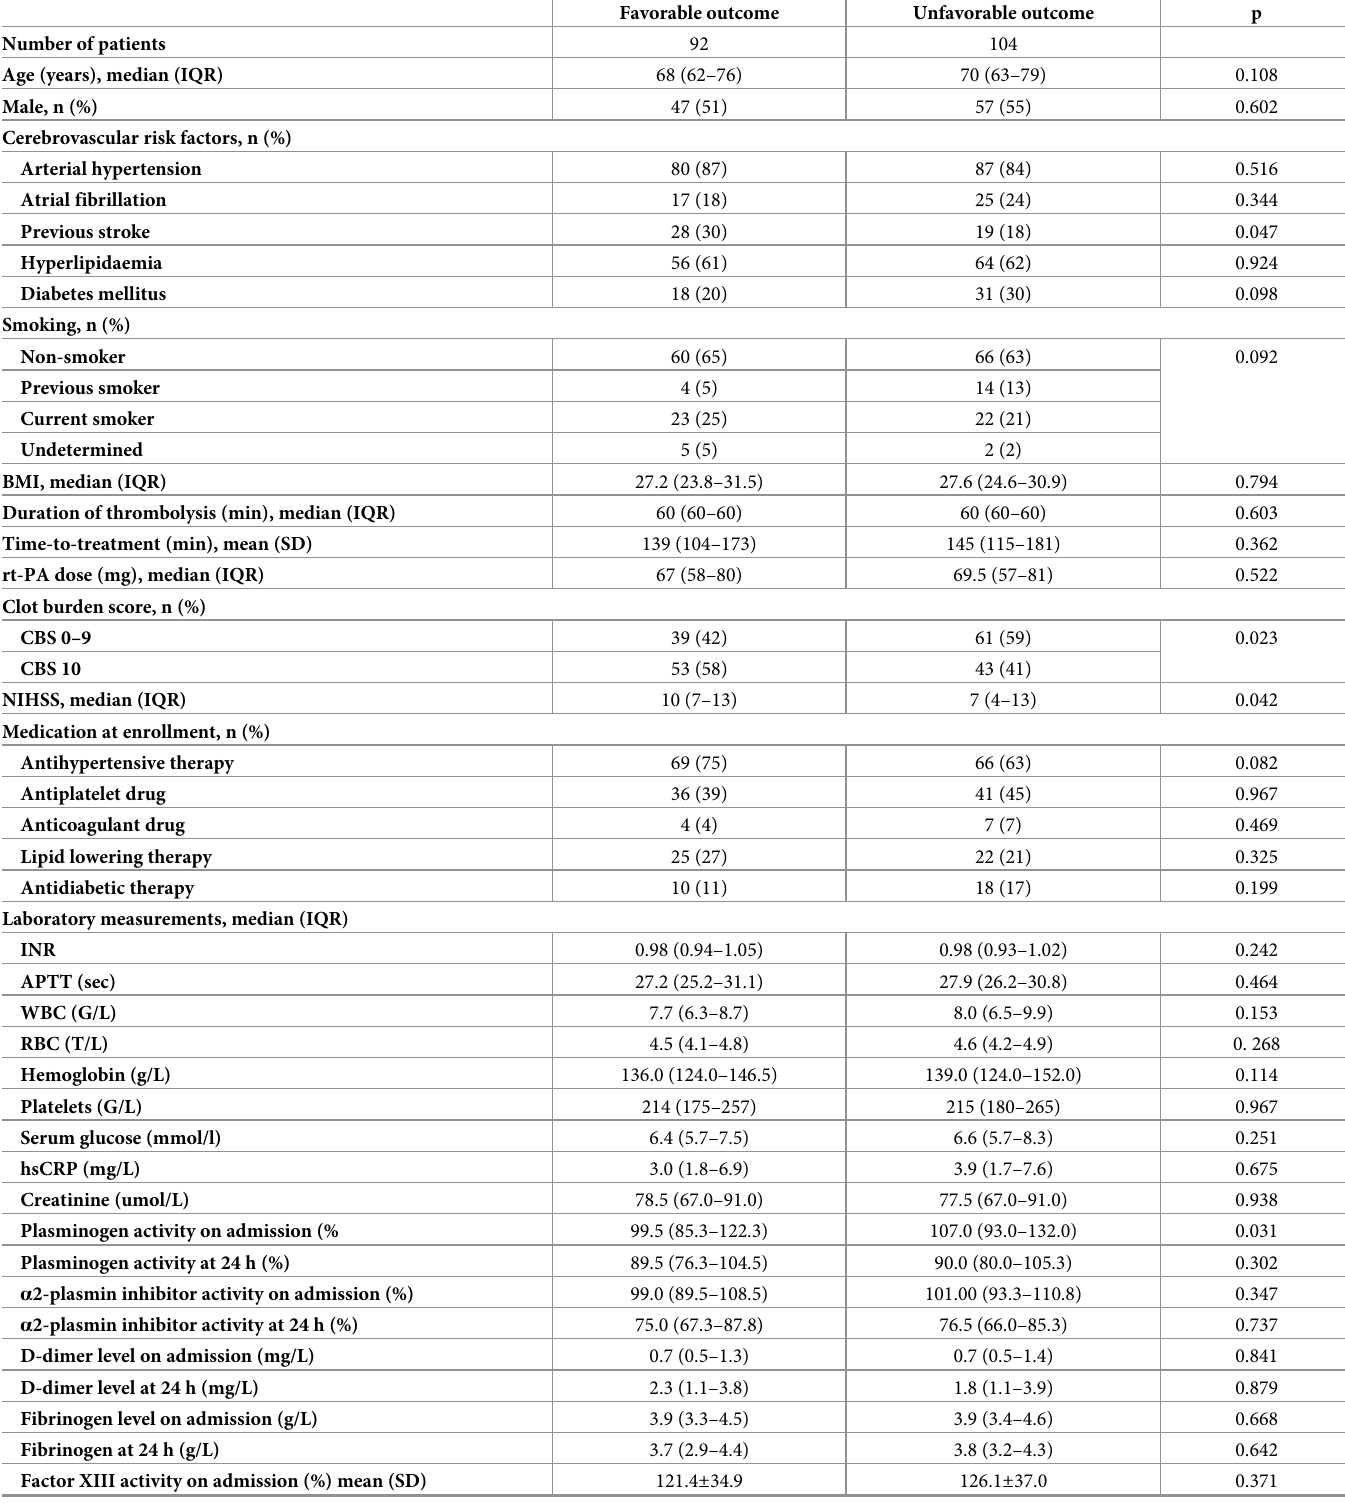
Table 2. Baseline parameters and specific hemostasis markers according to short-term functional outcomes in the studied